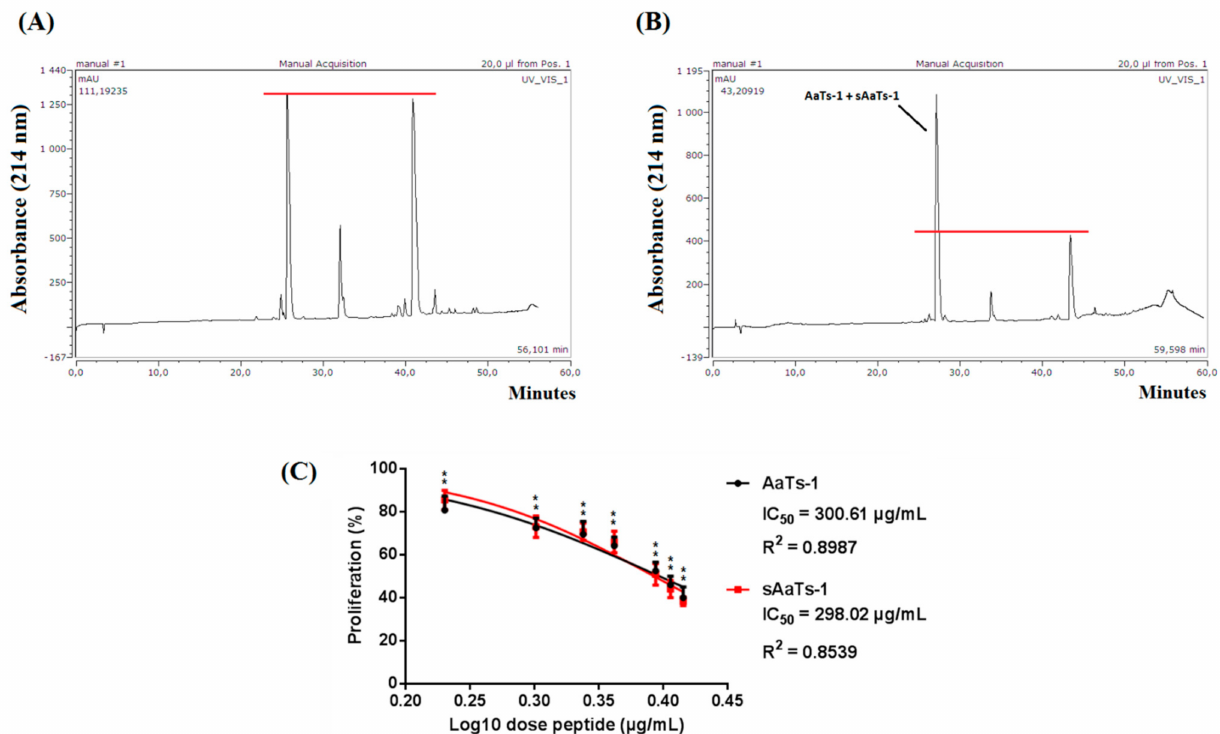
Figure 6. Purification of the synthetic AaTs-1. ( A ) A quantity of 15 µ g of the synthesis product was injected into a C18-HPLC column. Elution was carried out with a linear gradient (34 min) from 15% to 30% of 0.1% TFA/acetonitrile. The flow rate was 0.8 mL/min. The absorbance was measured at 214 nm. ( B ) A quantity of 5 µ g of the synthesis product was co-injected with an equal amount of the native peptide under the same conditions. ( C ) Dose-response effect of AaTs-1 and sAaTs-1 (50–400 µ g/mL) on U87 cell proliferation: The cells were treated with a different concentration of native or synthetic peptide and incubated for 72 h at 37 ◦ C. Mean, SD. * p < 0.05, significantly different from control.